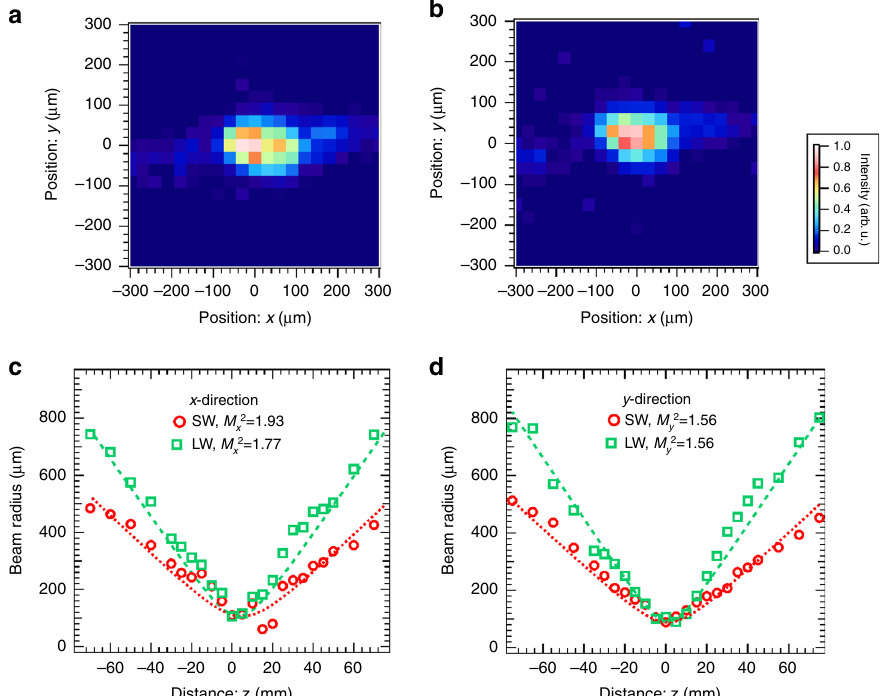
Fig. 5 Measurement of the spatial pro fi les of the output pulses from OPA3. a Beam pro fi le of the short-wavelength (SW) component at the focal point. b Beam pro fi le of the long-wavelength (LW) component at the focal point. The x - and y -directions are de fi ned as parallel and perpendicular to the optical table, respectively, in both fi gures. The offsets of the positions in the x - and y -directions are common in a , b . c Evolution of the beam radius (half width at e − 2 maximum) in the x -direction with the beam propagation across the focal point. Circles and squares denote the radii of the short- and long-wavelength components, respectively. We evaluated the M 2 value for each wavelength component by fi tting each measured radius. Resultant fi tting curves are shown as dotted and dashed curves for the short- and long-wavelength components, respectively. d Evolution of the beam radius (half width at e − 2 maximum) in the y -direction. Symbols and traces are de fi ned as in c